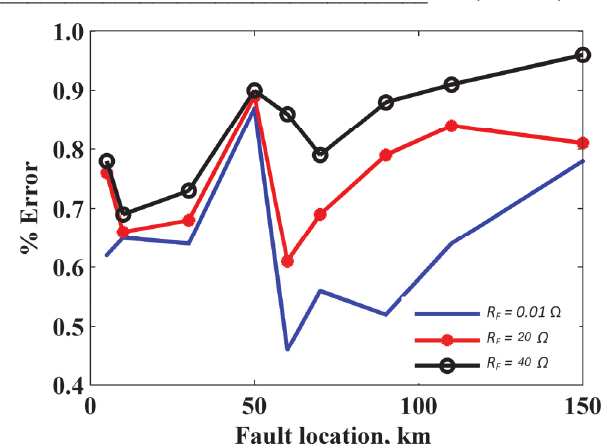
Fig. 11. Percentage of fault location error versus fault distance for L-G fault with FIA = 0°.